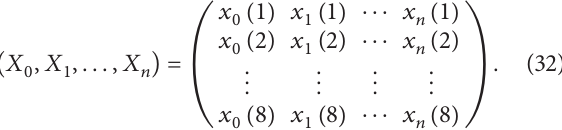
Table 2: Simulation parameters.